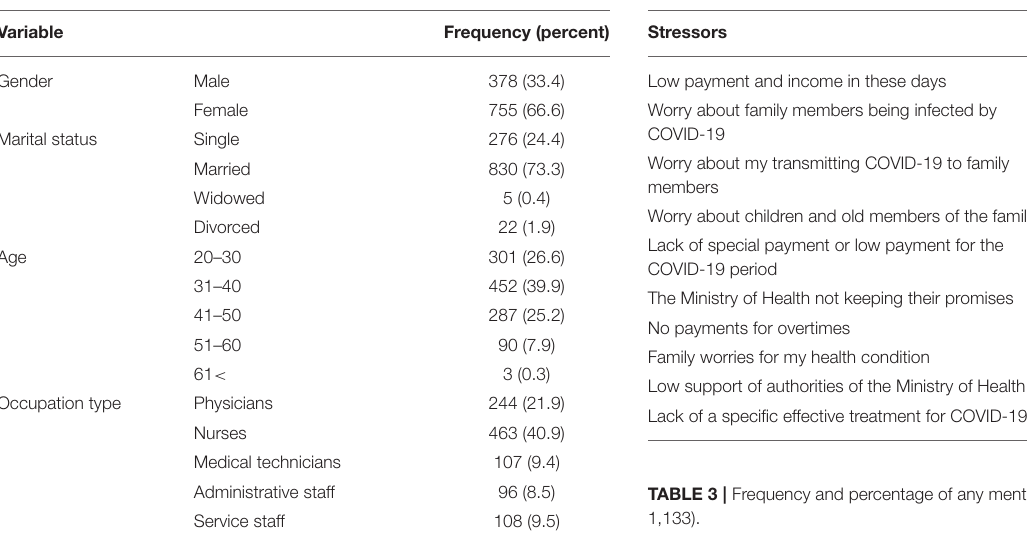
TABLE 1 | Demographic data of the study sample ( n = 1,133). TABLE 2 | Top 10 ranks of reported stressors among total sample ( n = 1,133).